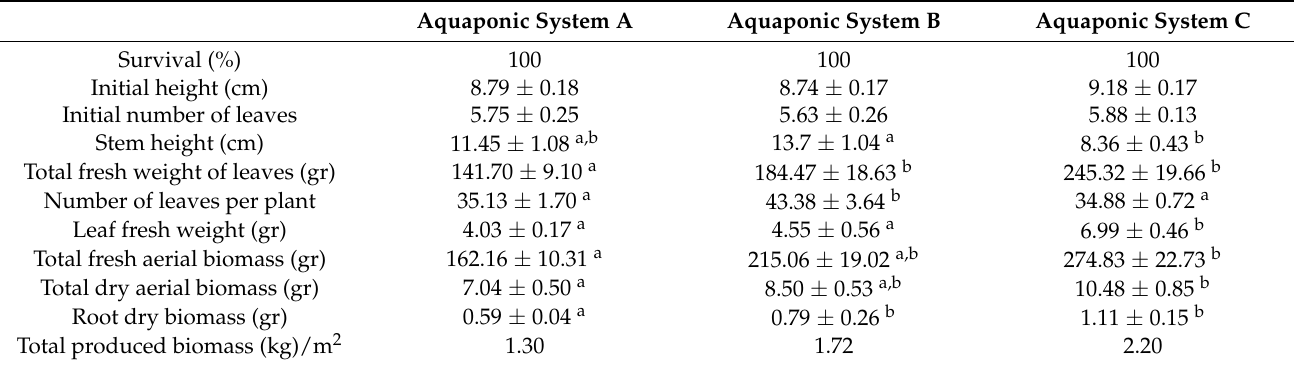
Table 7. Plant growth performance over 45